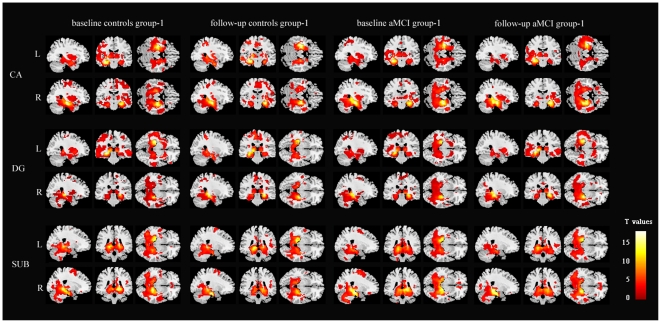
Validation of the networks of hippocampal subregions in aMCI group-1 and healthy controls group-1 at baseline and follow up.Distributed brain networks were demonstrated across the majority of clusters including diffuse subcortical, medial frontal, temporal cortical, parietal and cerebellar sites. Thresholds were set at P<0.05, corrected by FDR.